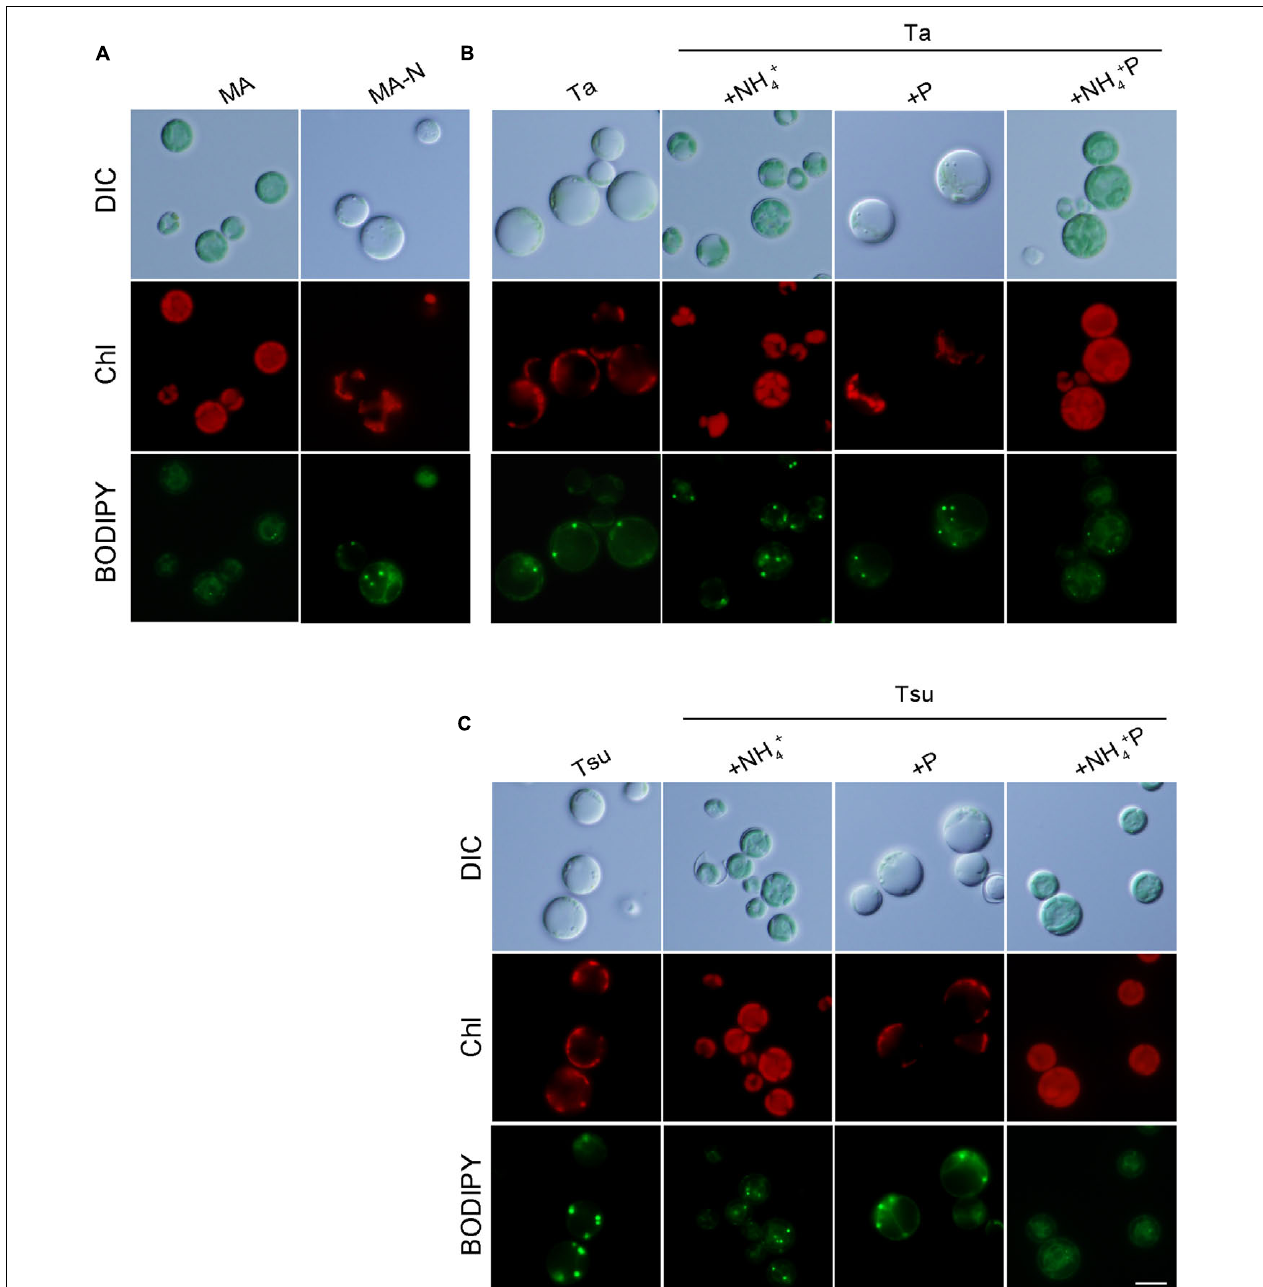
FIGURE 2 | Microscopic observation of G. sulphuraria 074G cells in MA, MA-N and media derived from acidic hot spring waters. (A–C) Micrographs of cells that were cultured in the respective media. Cells cultured in synthetic MA medium (OD 750 of 1.0–2.0) were collected by centrifugation, resuspended into the respective media to give an OD 750 of 1.0 and then cultured for 7 days. Images obtained by differential interference contrast microscopy (DIC), autofluorescence of chloroplasts (Chl) and BODIPY staining (BODIPY) are shown. Scale bar = 5 µ